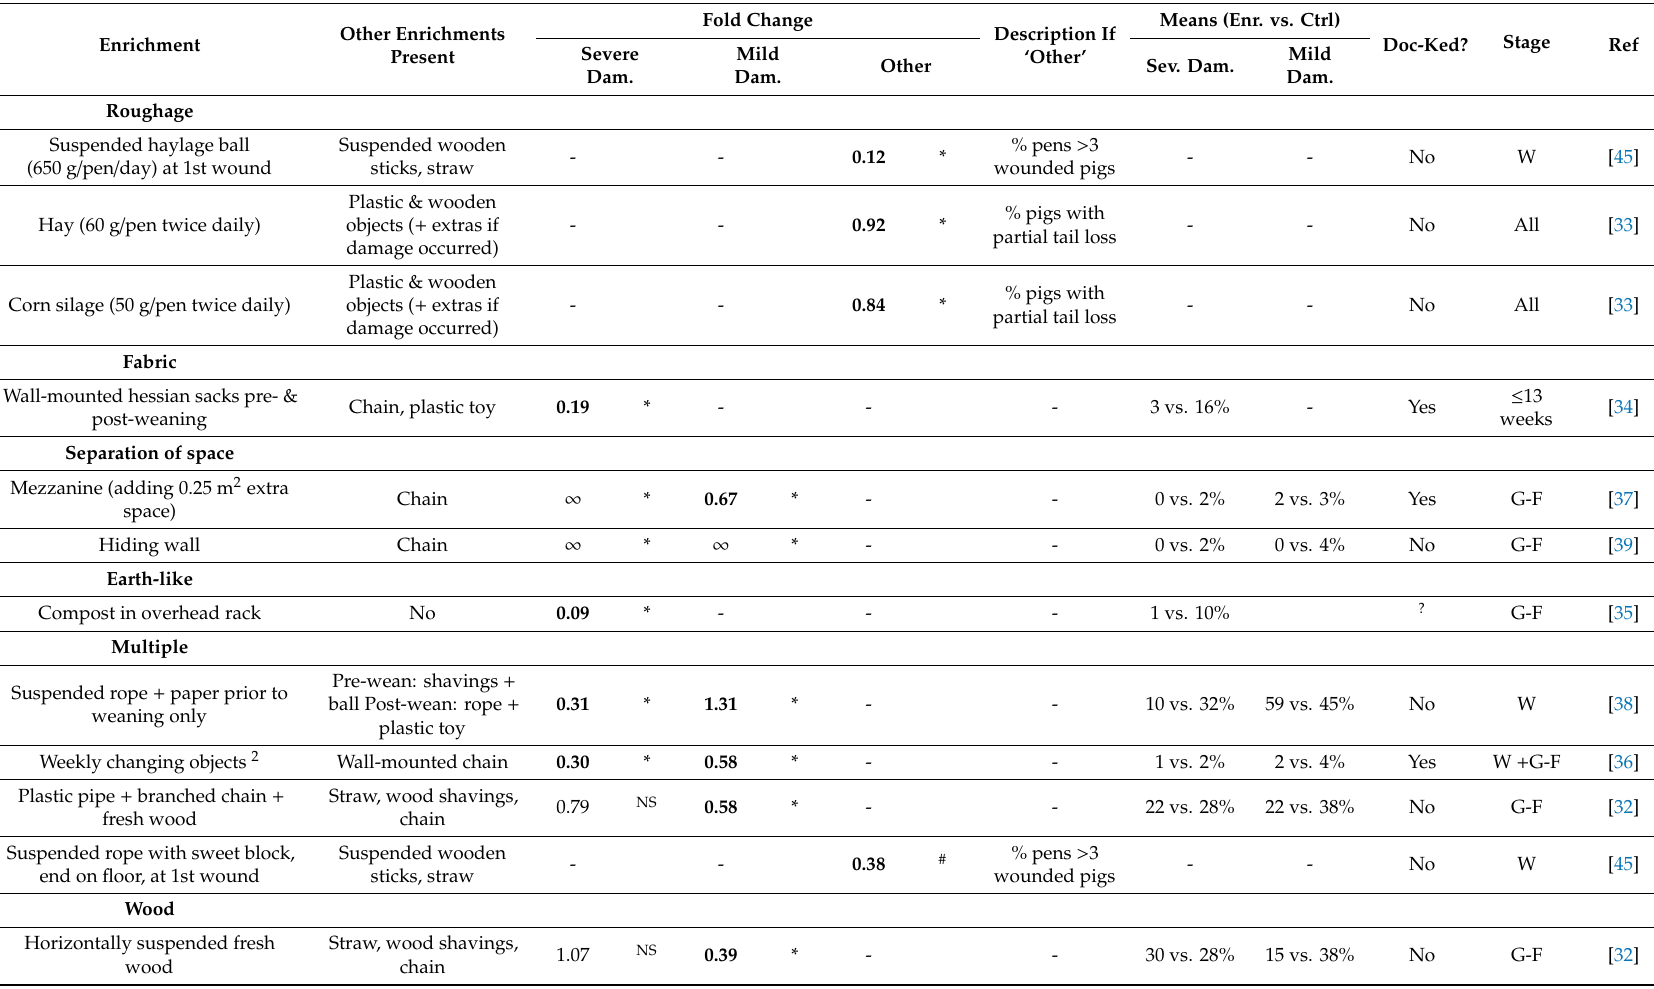
Table 1. E ff ects of environmental enrichment on tail damage ordered by type of enrichment (most successful types at the top of the table). Enrichment